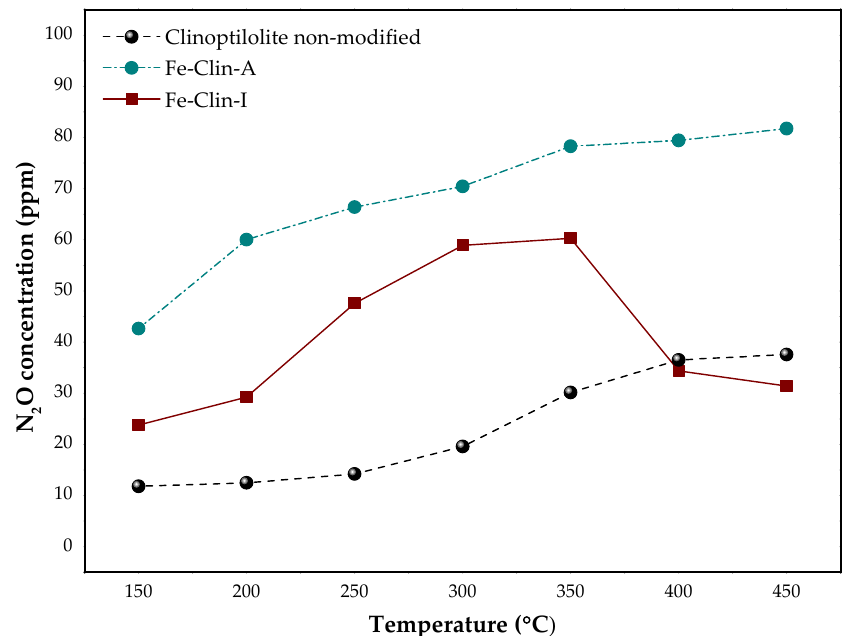
Figure 6. The results of N 2 O concentration during NH 3 -SCR process obtained for non-modified clinoptilolite, Fe-Clin-A, and Fe-Clin-I at GHSV = 26,500 h − 1 .